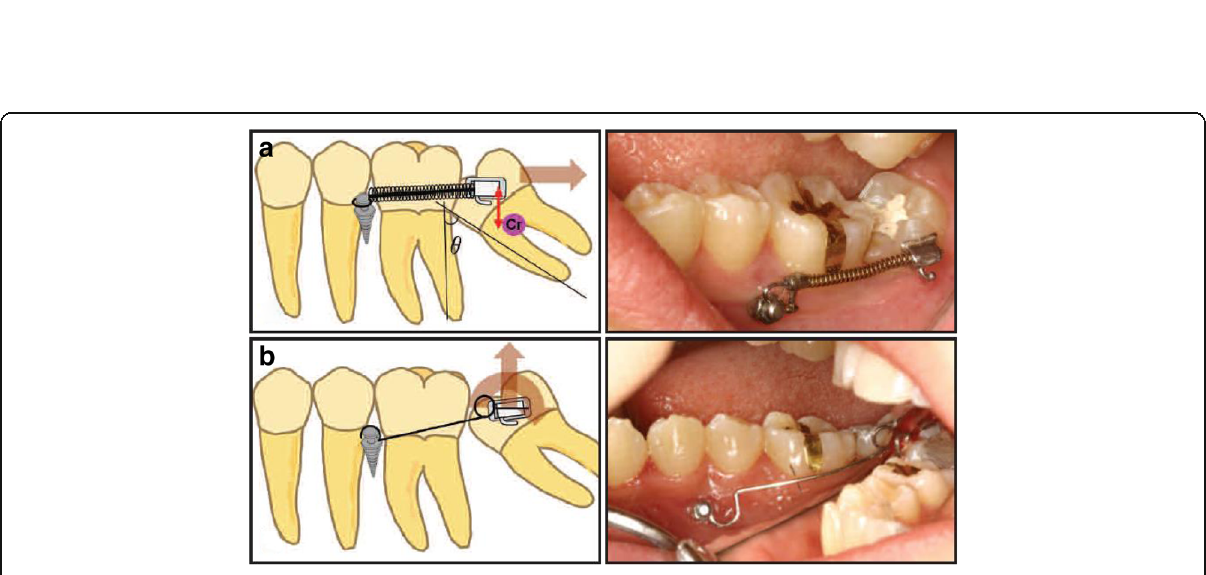
Fig. 5 Uprighting of a mesially impacted #37 with miniscrew anchorage, an open coil spring and a stainless steel uprighting spring. a Step 1: Unlocking of the second molar with distalizing force from .016 in. stainless steel wire and open coil spring. b Step 2: Uprighting of the second molar with tip back moment from .016×.022 in. stainless steel wire spring (from Lee et al. [4], with kind permission of Journal of Clinical